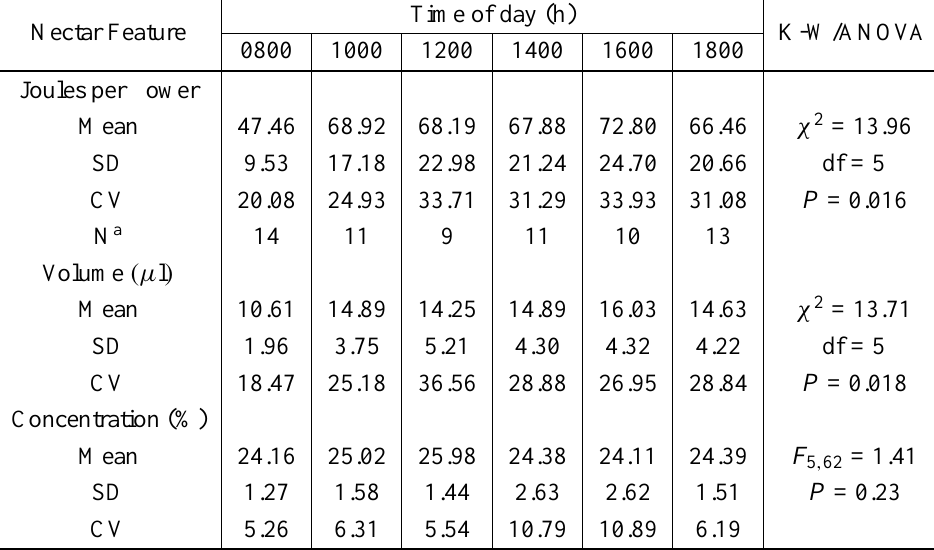
Cumulative nectar production (volume and concentration) in Palicourea crocea flowers through- out the day in the Upper Paraná River floodplain. SD: standard deviation; CV: coefficient of variation (%). K-W/ANOVA: results of Kruskal-Wallis (χ 2 ) or one-way ANOVA ( F ).